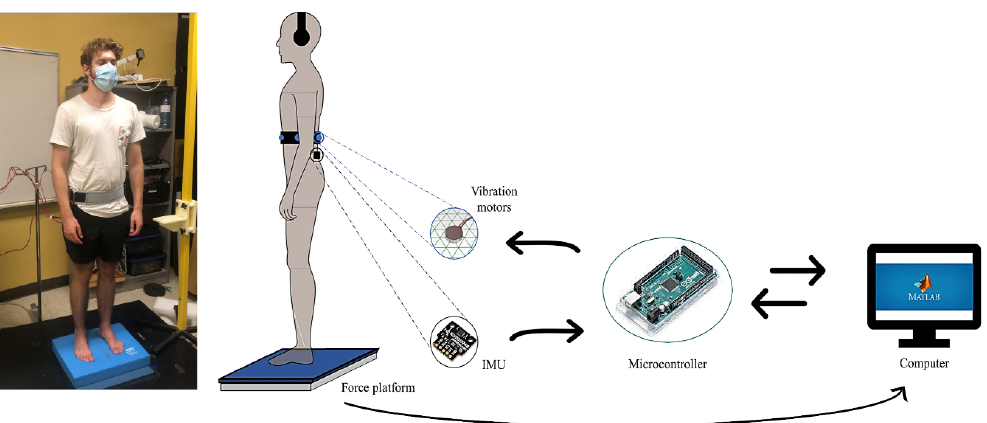
Figure 1. Experimental set-up. The participant stood still on a force platform (or on a foam placed on the force platform) wearing headphones and the vibrotactile feedback device, which implied an IMU located at the level of the superior iliac crest. A microcontroller processed IMU data and activated or deactivated the vibration motors according to body sway amplitude and direction. IMU and force platform data were acquired using MATLAB. The picture on the left depicts a participant during the pilot study. The vibration motors are under the t-shirt directly in contact with the skin of the participant. They are securely fixed with tape and covered with an elastic band, while the gray elastic belt holds the IMU. Note, this pilot participant did not wear headphones, but all other participants wore headphones.